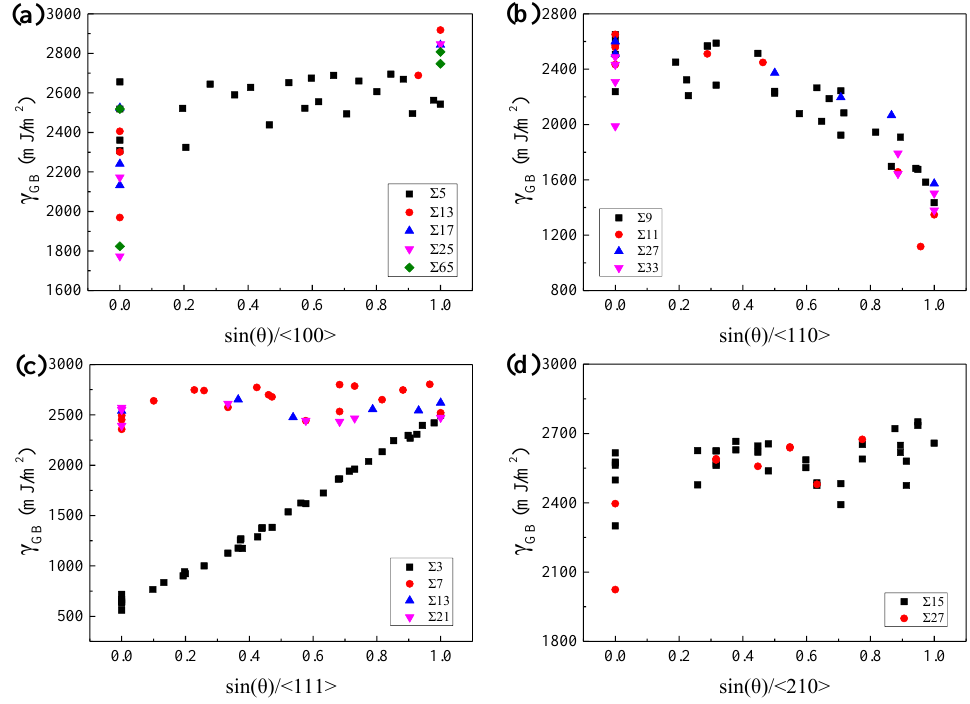
Figure 6. The GBEs of W at 2400 K as a function of sin( θ ) for GBs with the misorientation axis of ( a ) <100>, ( b ) <110>, ( c ) <111>, and ( d ) <210>, respectively.